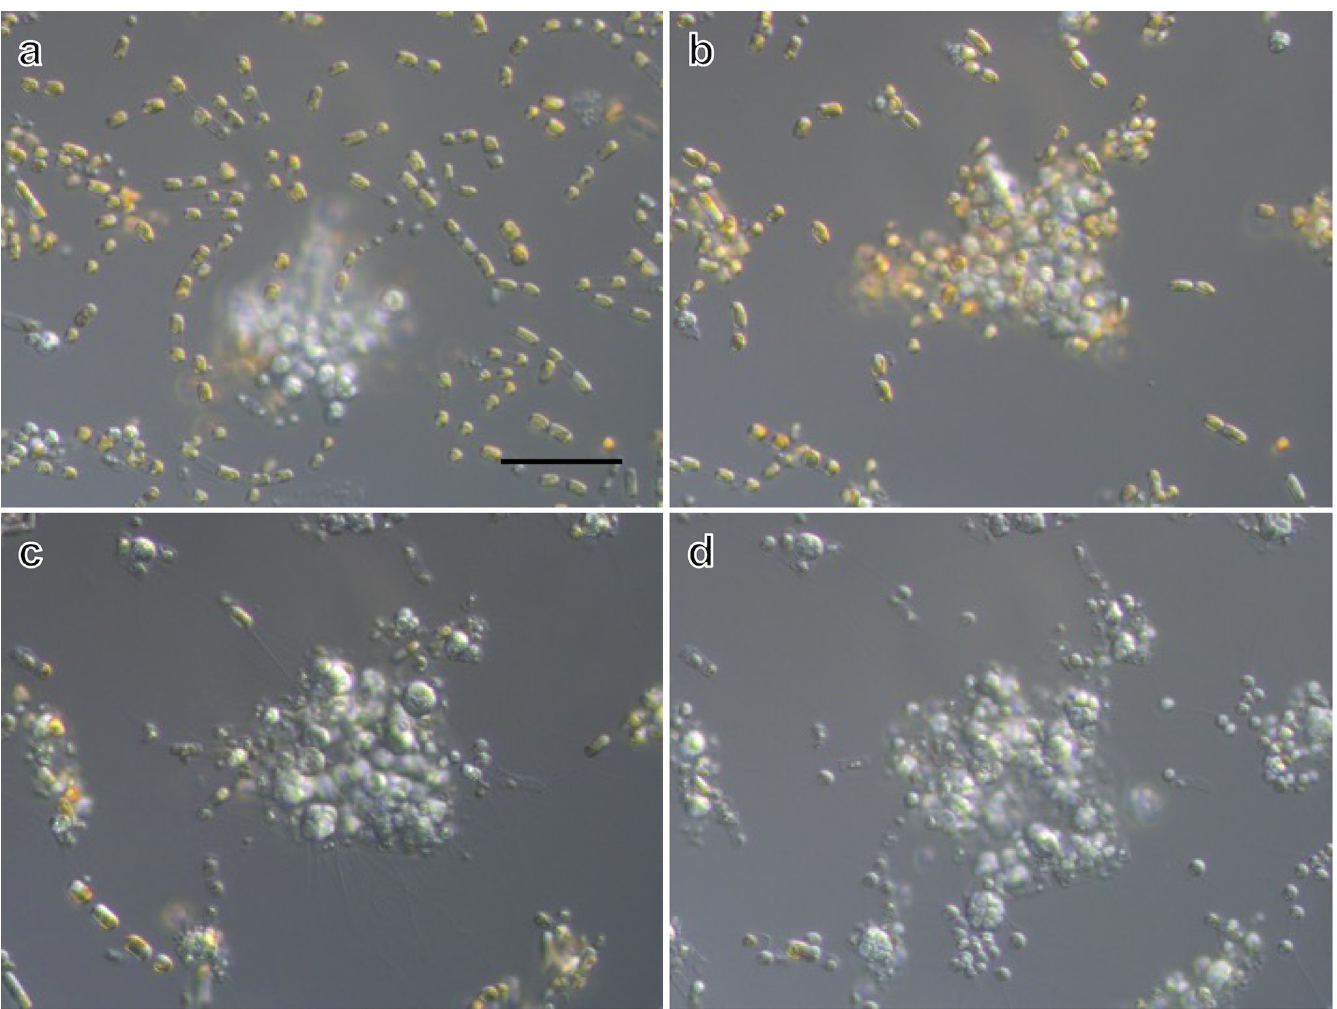
Fig 1. Continuous observations of Aplanochytrium and Skeletonema in two-membered cultures. (a) Yellow living Skeletonema (NIES 324) cells dispersed around small white Aplanochytrium (SEK 717) colony, 0 min. (b) Yellow Skeletonema cells aggregated around Aplanochytrium colony by ectoplasmic nets, 174 min. (c) White Skeletonema cells forming aggregates with Aplanochytrium cells, 603 min. At this stage, ectoplasmic nets developed radially from Aplanochytrium colony. (d) Nutrition intake from Skeletonema cells by Aplanochytrium almost complete (843 min), accompanied by release of small spherical aplanospores. Scale bar = 50 μ m. These continuous observation images can be viewed as a time-lapse video movie (S1